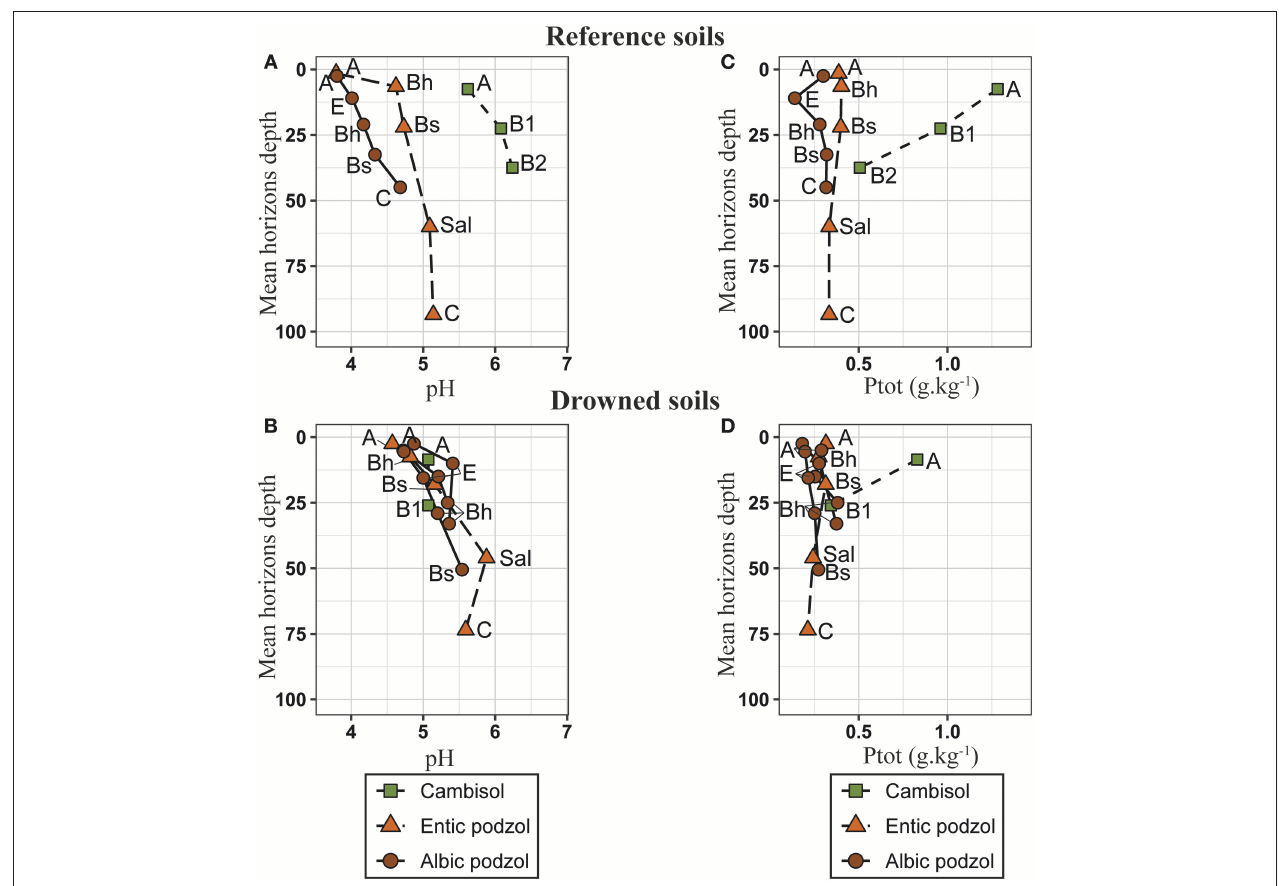
FIGURE 7 | pH water of the horizons of reference soils (A) and drowned soils (B) . Ptot (g.kg − 1 ) of the horizons of reference soils (C) and drowned soils (D) . Holorganic horizons are not shown. Green square: Cambisol. Orange triangle: Entic Podzol. Brown dot: Albic Podzol. Horizon names are specified beside each